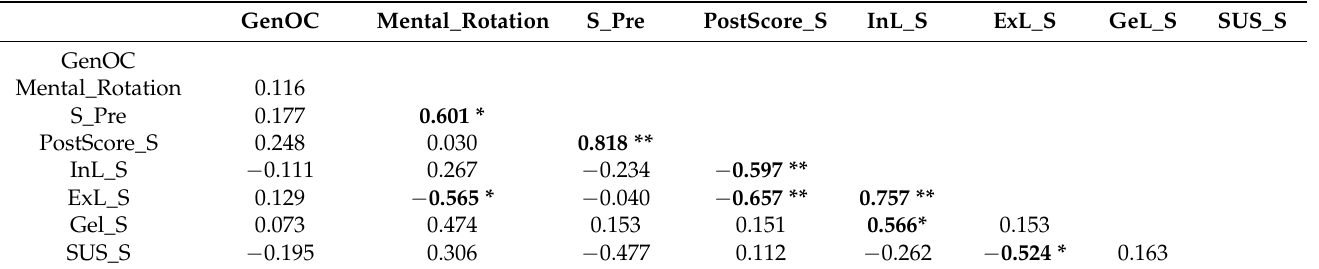
Table 4. Correlations for group two (AR) for the topic